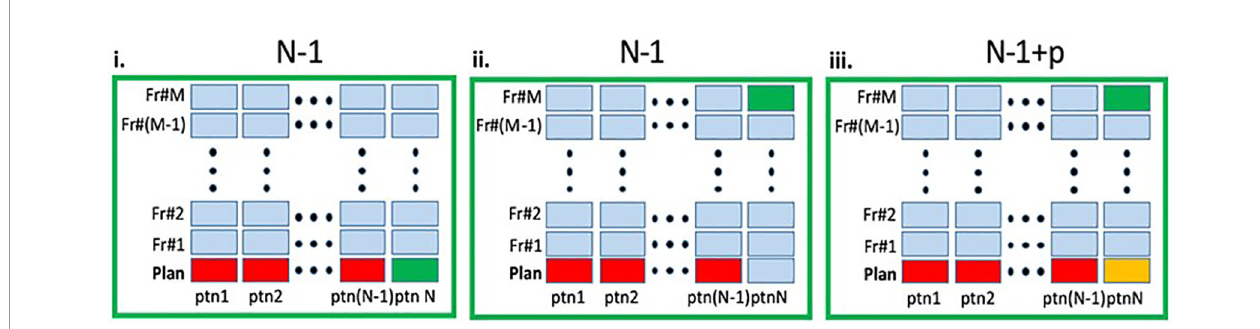
FIGURE 2 | Schematic representation of the experimental design. In each panel the columns represent the MRIs (planning and fraction 1 to M) for a given patient. The entire dataset contain total of N×(M+1) MRIs. i. Leave-one-out (LOO) : A deep learning (DL) network, marked as N - 1 was trained on the planning MRIs (red) from N - 1 patients and tested on the planning MRI of the left-out patient (green). ii. RT-Fr : The N - 1 network was tested on an MRI from an online adaptable radiotherapy fraction of the "left-out" patient (green). Note that the planning MRI from this patient was not used in the training. iii. Transfer learning : The planning MRI for patient N (yellow) is added to the N - 1 network, resulting in N - 1+p network, which is then tested on an MRI from RT-Fr of the "left-out" patient (green).